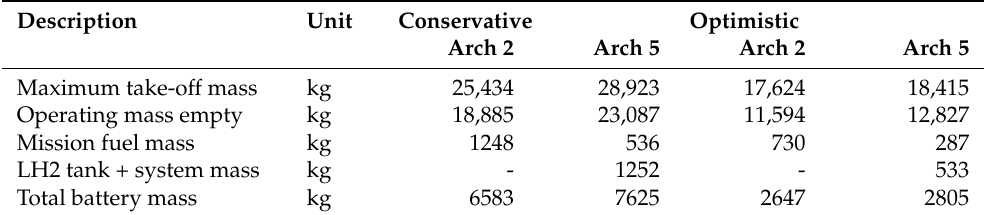
Table 10. Results on the essential masses from the initial sizing for Architecture 2 (SAF) and 5 (LH2). Description